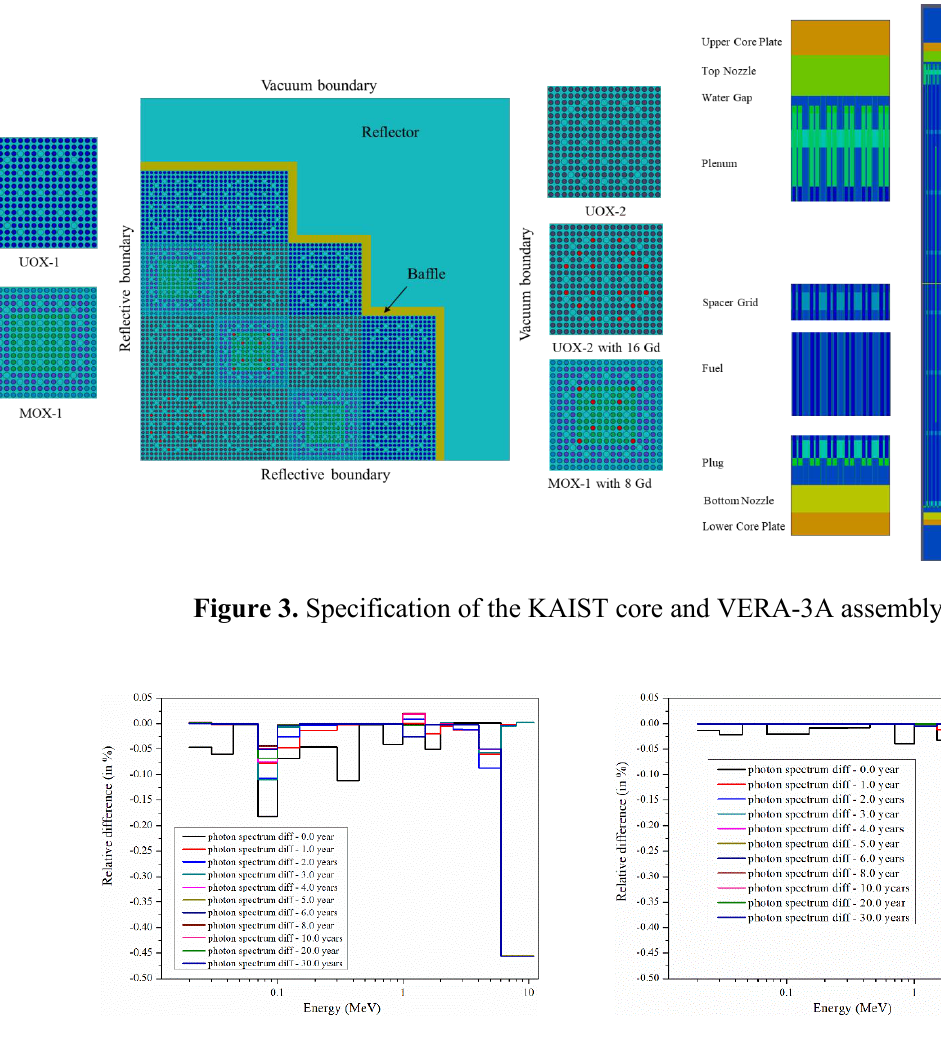
Figure 4. Relative difference of photon spectra of the VERA-3A and KAIST